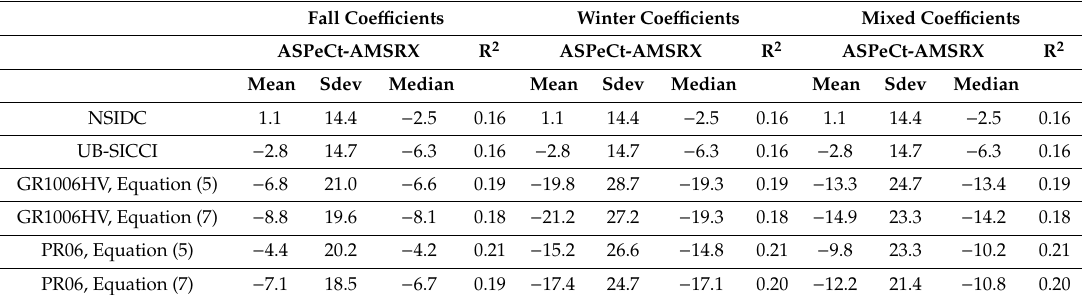
Table 3. The mean, standard deviation of the mean (sdev) and median di ff erence of the ASPeCt minus AMSR-E / AMSR2 (AMSRX) snow depth, and the squared correlation of a linear regression “R 2 ”. All quantities except R 2 are given in centimeters. See Figure 8 and text for more details.